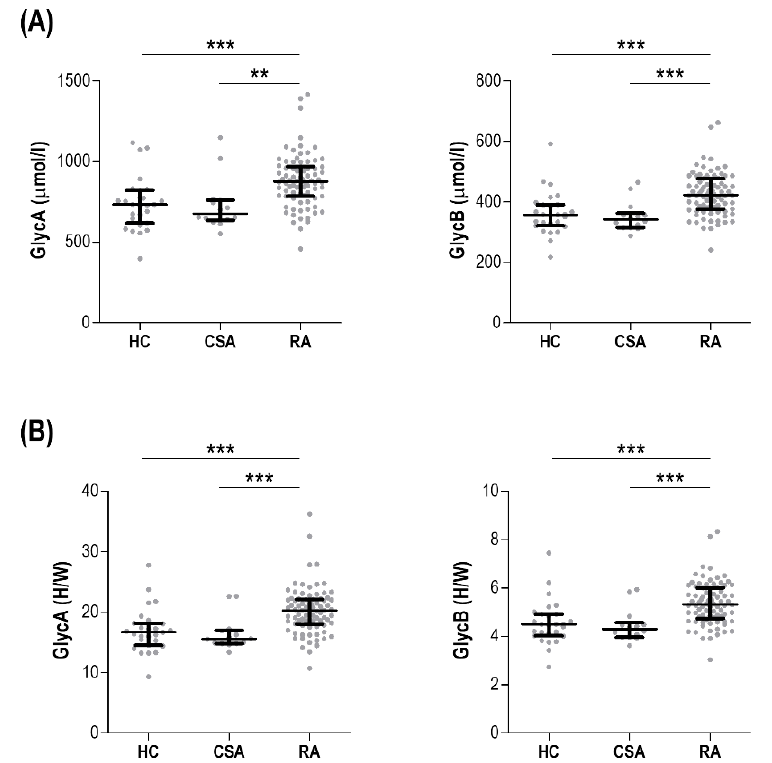
Figure 1. Comparative analyses of glycoprotein signals across study groups. Glycoprotein levels (GlycA and GlycB) measured as absolute levels ( A ) or height to width (H / W) ratios ( B ) were compared across healthy control (HC), clinically-suspect arthralgia (CSA) individuals, and early rheumatoid arthritis (RA) patients. Each dot depicts an individual, bars represent medians, and whiskers correspond to 25th and 75th percentiles. Di ff erences were assessed by Kruskal–Wallis tests with Dunn–Bonferroni posthoc tests. The p -values from the latter were indicated as follows: ** p < 0.010 and *** p < 0.001. In RA patients, GlycA and GlycB levels were correlated with DAS28 (r = 0.306, p = 0.006